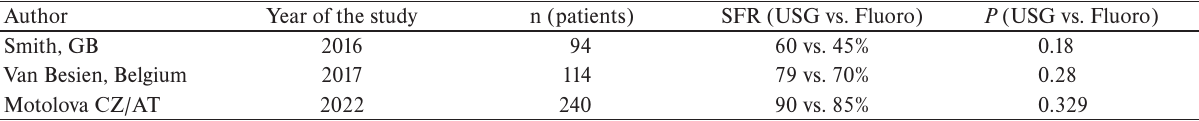
Table 6. Overview of the available studies focused on equivalence of flouoscopic and USG